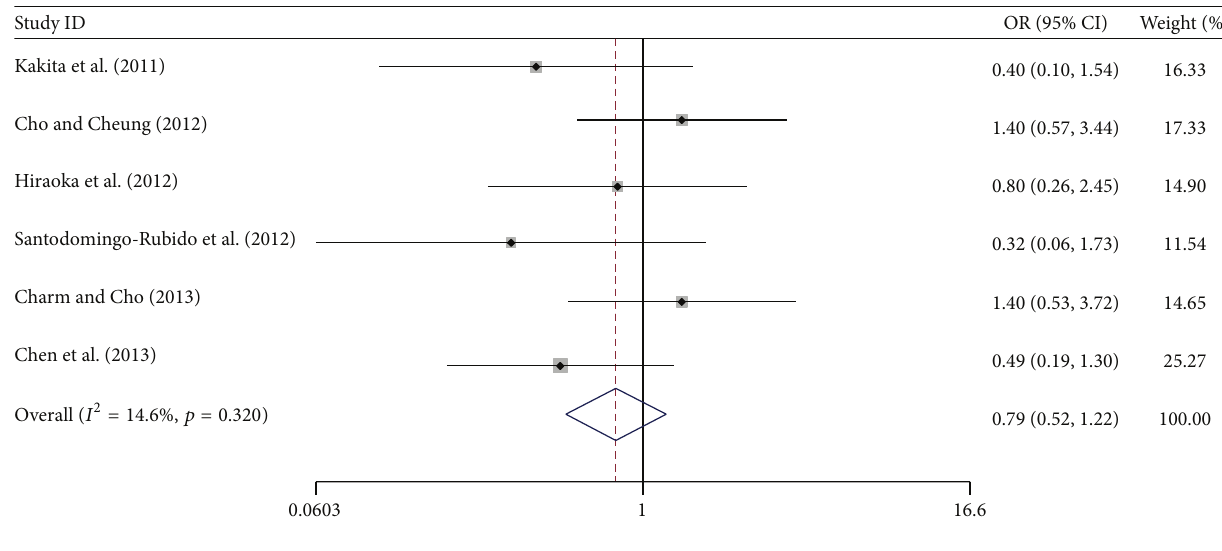
Figure 3: Odds ratios (OR) of dropout rates between orthokeratology and controls at 2-year